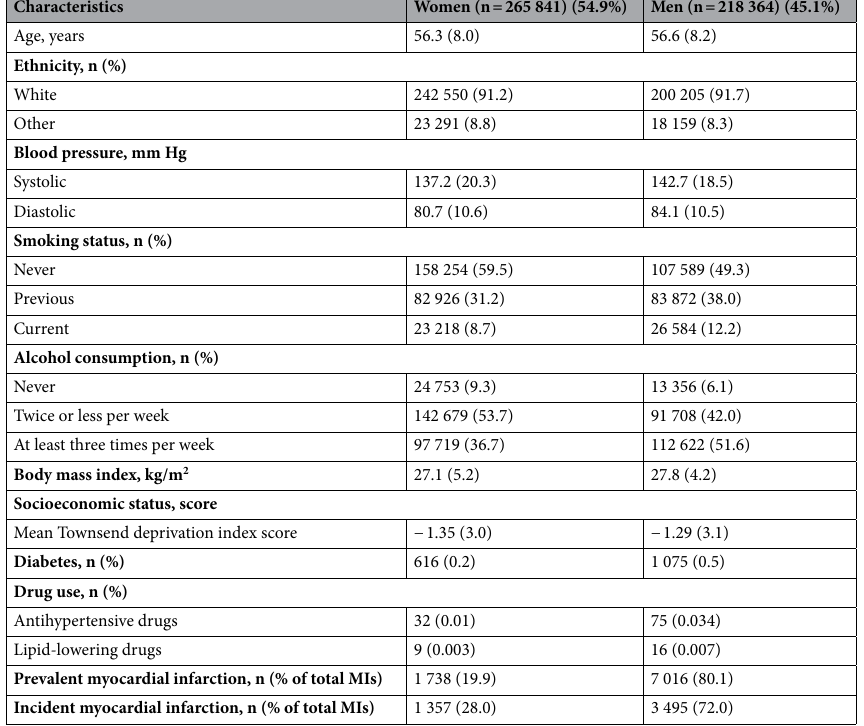
Table 2. Characteristics of study participants. Values are presented as mean and standard deviation (SD) in brackets for continuous variables and as number of participants (n) and percentage (%) for categorical